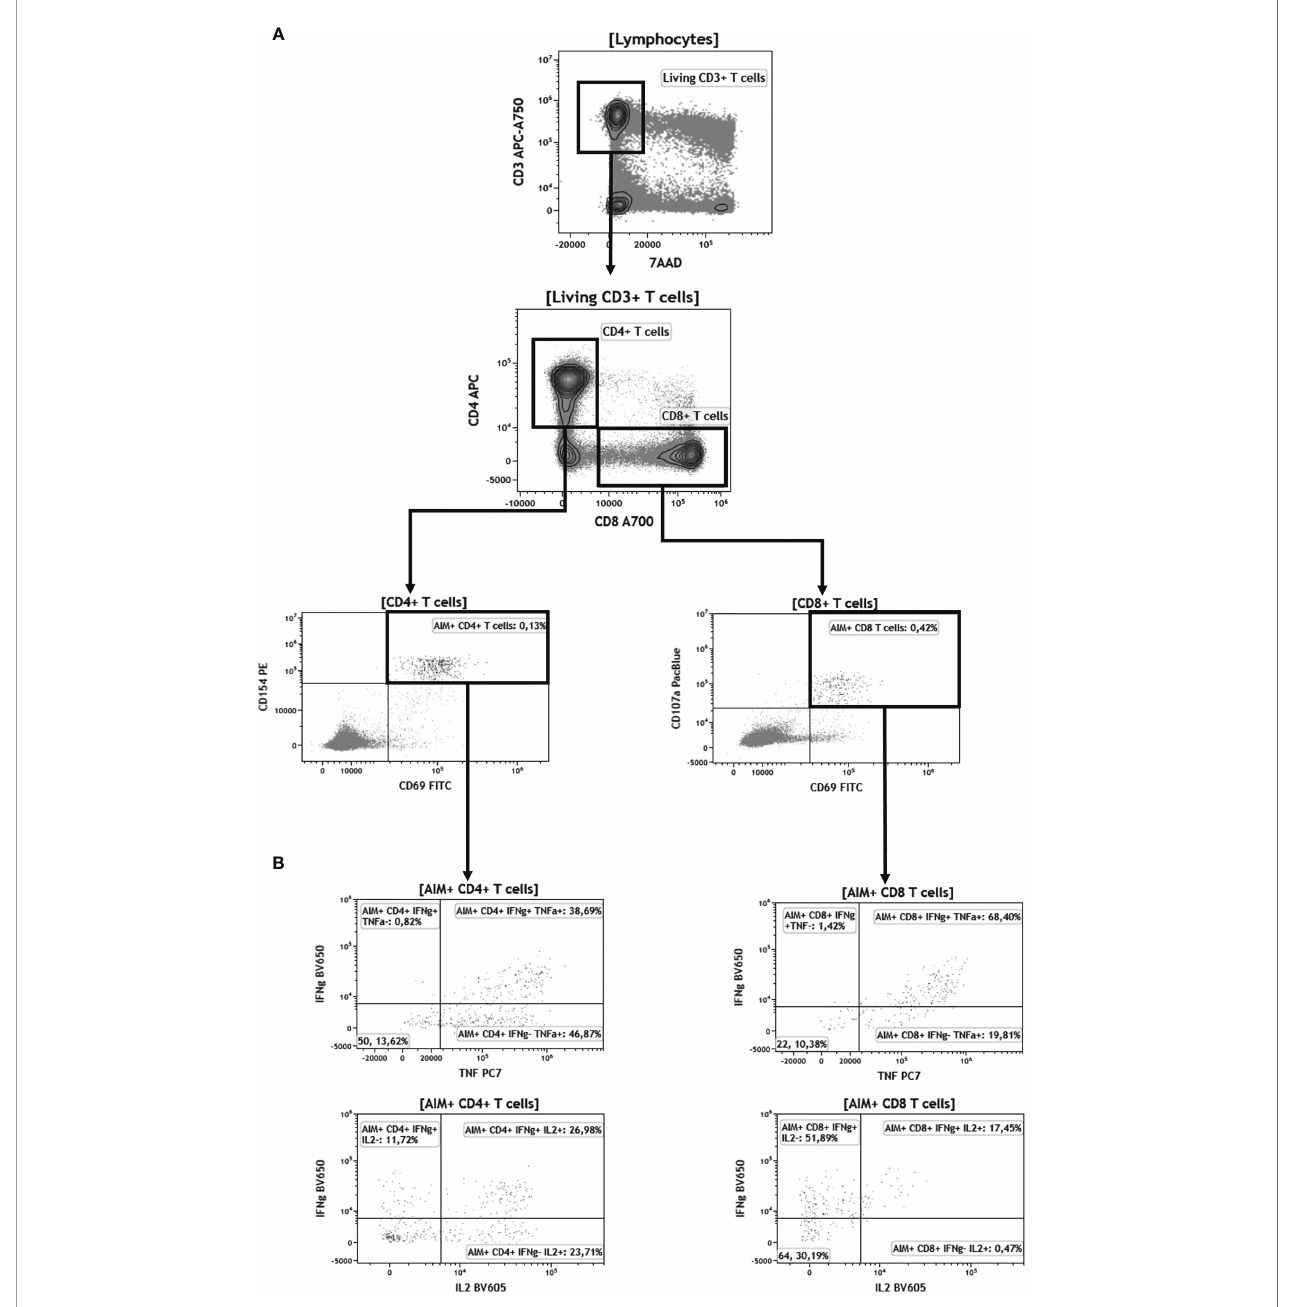
FIGURE 4 | Gating strategy for fl ow cytometry analyses of CD4 + and CD8 + T cells after BNT162b vaccination. (A) Identi fi cation of activation induced markers (AIM + cells). Brie fl y, “ living CD3 + T cells ” are identi fi ed as 7-aminoactinomycine D (7AAD)-negative and CD3-positive cells. Among this population, CD4 + and CD8 + T cells are selected according to CD4 + and CD8 + expression, respectively. AIM + cells among CD4 + T cells are both CD154 + and CD69 + . AIM + cells among CD8 + T cells are both CD107a + and CD69 + . (B) Representative plots displaying IFN g , IL-2, and TNF a expression among AIM + CD4 + and CD8 + T